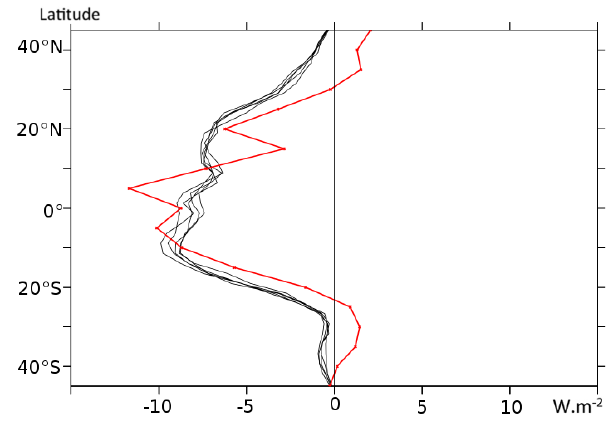
Fig. 1. Comparison of August 1991 absorbed shortwave radiative fluxes (SW, in Wm − 2 ) at the top of the atmosphere (TOA) anoma- lies from Earth Radiation Budget Satellite (ERBS) observations (red) and 5 members simulation ensemble with the IPSLCM4v2 model (black). The simulated anomalies are computed as the dif- ferences between the Mt Pinatubo simulations and the control run. ERBS TOA SW radiative fluxes anomalies are expressed relatively to a 1985 to 1989 base